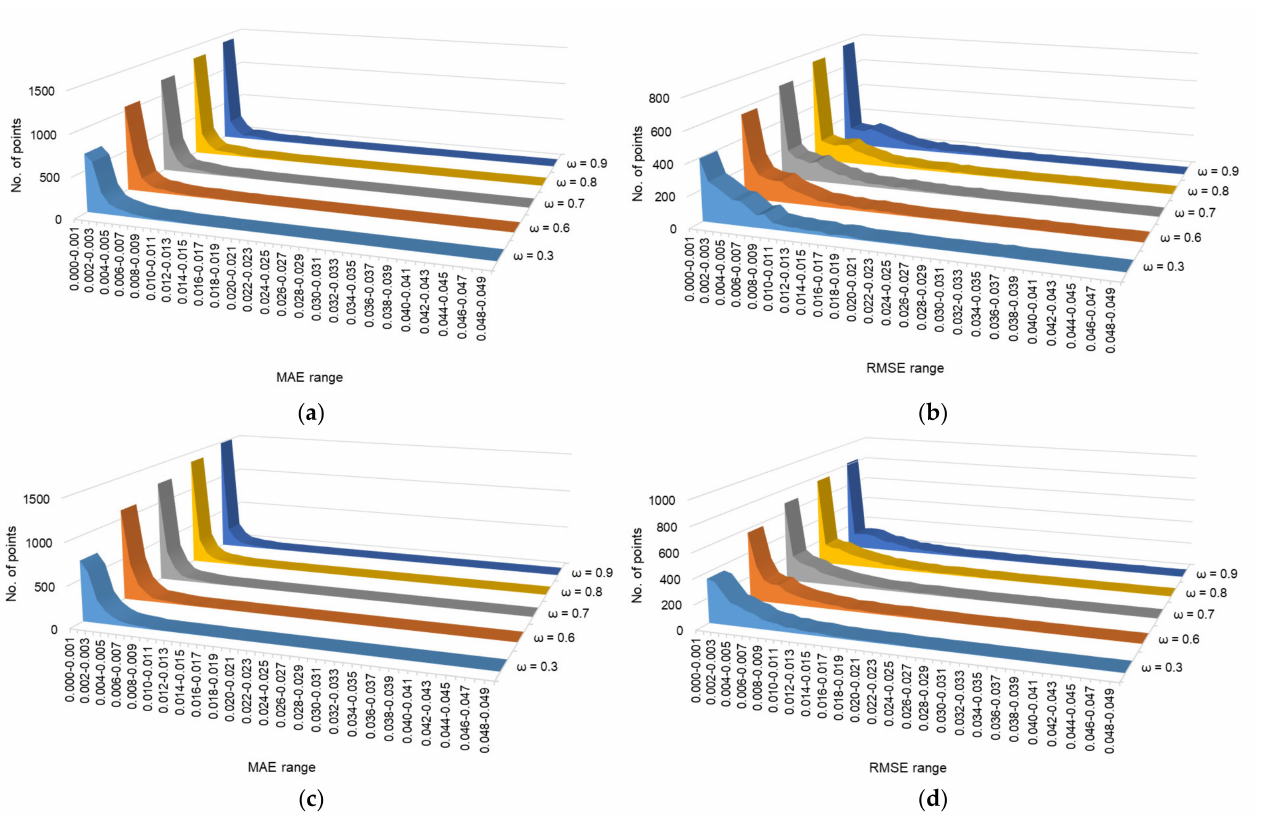
Figure 13. ( a , b ) The comparison between W-P-ATTs with different ω —u_current, ( c , d ) The com- parison between W-P-ATTs with different ω —v_current. The subfigure ( a ) is MAE distribution for u_current and the subfigure ( b ) is RMSE distribution for u_current. The subfigure ( c ) is MAE distribution for v_current and the subfigure ( d ) is RMSE distribution for v_current.